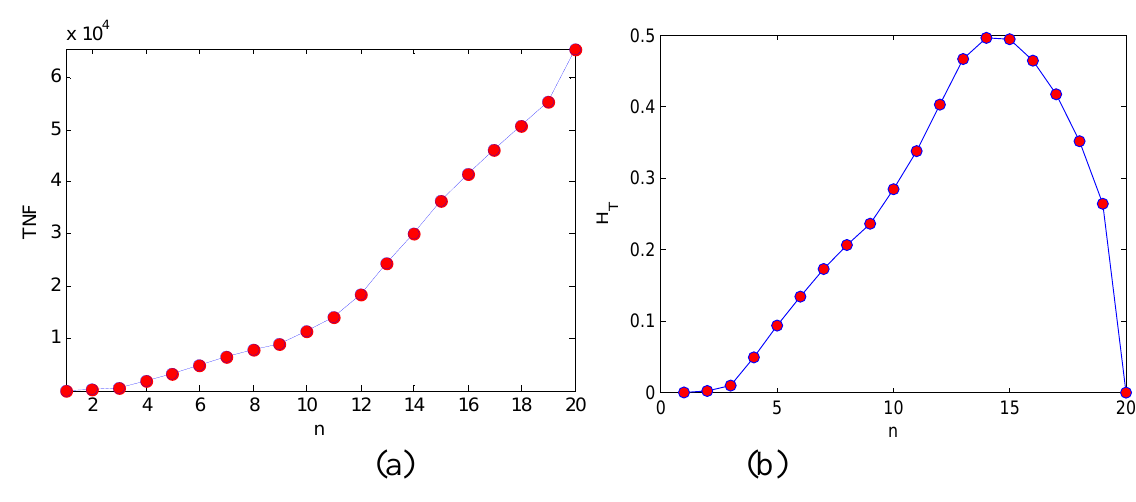
Figure 4. Feature extraction. (a) G [ n ]. (b) T [ n ].